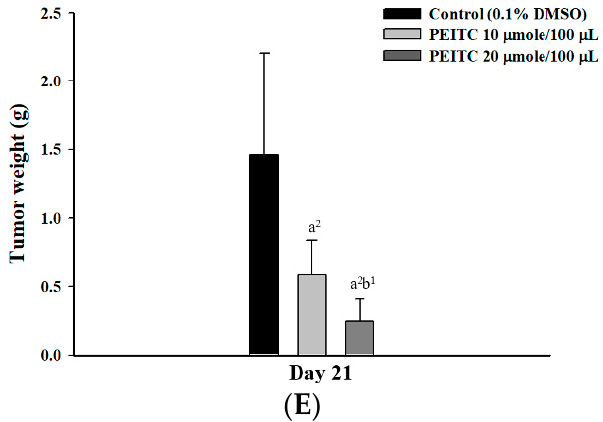
Figure 2. Therapeutic efficacy evaluation of PEITC in xenograft GBM 8401/ luc2 cells-bearing mice. ( A ) The tumor growth of each mouse was monitored by bioluminescent imaging (BLI) every one week. The tumor growth was significantly suppressed by PEITC at both doses (PEITC-10, PEITC-20) compared to the control group. ( B ) The regions-of-interest (ROIs) of tumors in ( A ) were quantified. The PEITC-20 group revealed the most obvious tumor inhibition. a 1 : p < 0.05, a 2 : p < 0.01 compared to that of the control; b 1 : p < 0.05, b 2 : p < 0.01 compared to that of PEITC-10 group. ( C ) The tumor volumes of each mouse were assayed by caliper measurement every 3 days. The tumor volumes were significantly reduced by PEITC at both doses (PEITC-10, PEITC-20 groups) compared to the control group. a 1 : p < 0.05, a 2 : p < 0.01 compared to that of the control; b 1 : p < 0.05, b 2 : p < 0.01 compared to that of PEITC-10 group. ( D ) Six representative tumor pictures from each group are displayed after the mice were sacrificed. ( E ) The tumor weights of each mouse were assayed after they were sacrificed on day 21. The tumor weights were significantly decreased by PEITC at both doses (PEITC-10, PEITC- 20 groups) compared to the control group. a 2 : p < 0.01 compared to that of the control; b 1 : p < 0.05 compared to that of PEITC-10 group.